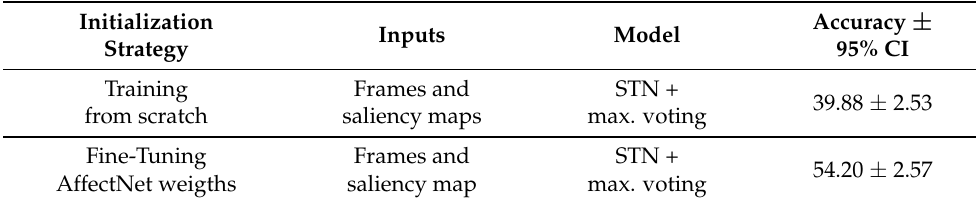
Table 2. Evaluation of different initialization strategies for Fine-Tuning the STN on RAVDESS: random initialization vs. weights from pre-trained STN on AffectNet